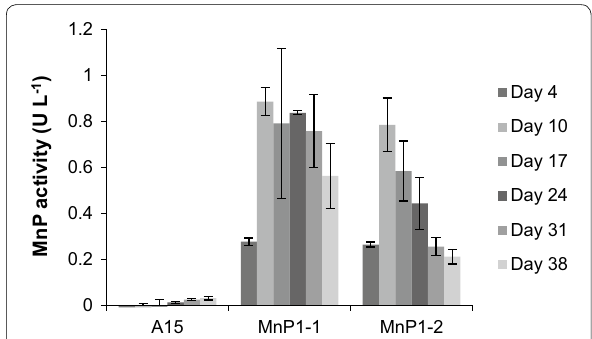
Fig. 1 MnP activity of A15, MnP1-1, and MnP1-2 in malt extract. Error bars indicate standard deviation of biological